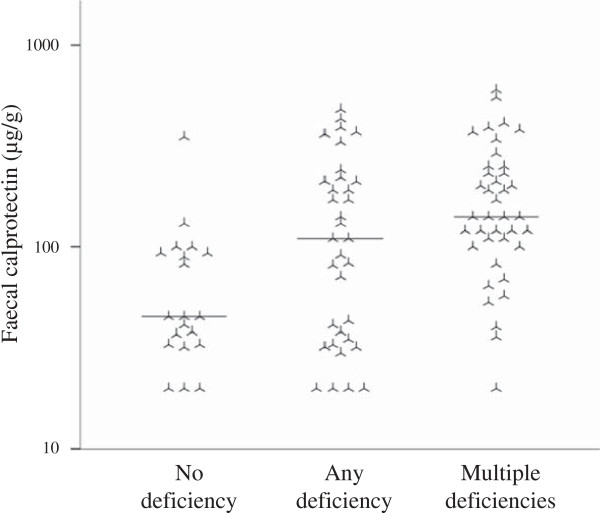
In systemic sclerosis, faecal calprotectin is associated with micronutrient deficiency. Individual and median faecal calprotectin levels in systemic sclerosis patients with different degrees of micronutrient deficiency. 1-way analysis of variance, P = 0.005. Please note the logarithmic scale on the y-axis. Patients were subject to analysis of the following micronutrient deficiencies by laboratory examination of serum or plasma: iron, vitamin B12, zinc and folic acid. Subjects with pathological testing according to local laboratory standards were regarded as micronutrient deficient. Patients with pathological testing for more than one of the aforementioned micronutrients were categorised as having multiple deficiencies.